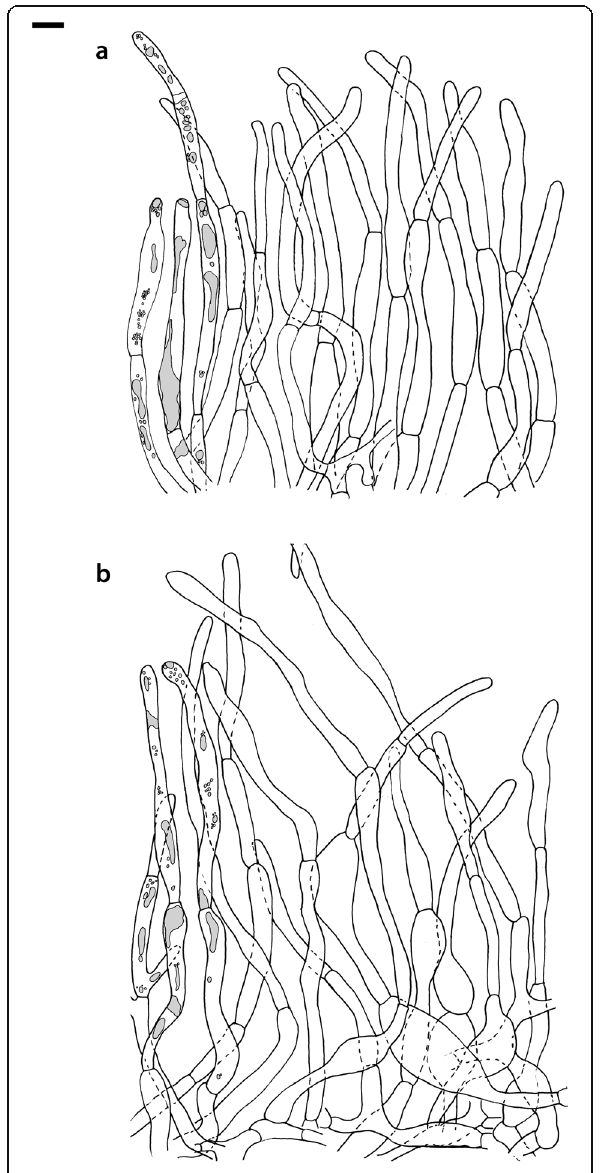
Fig. 17 Russula sp. 1 (RW 1975), hyphal terminations of the pileipellis. a Near the pileus margin. b Near the pileus centre. Bar=10 μ